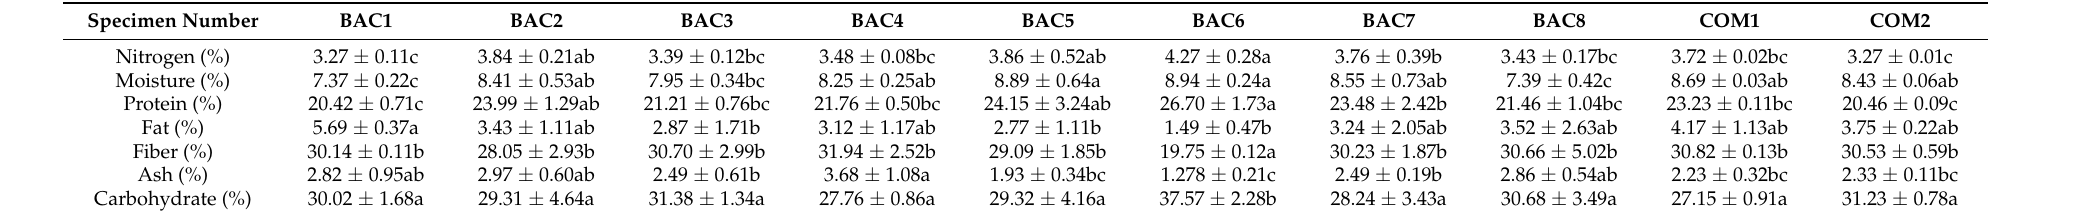
Table 3. Proximate compositions of Gymnema